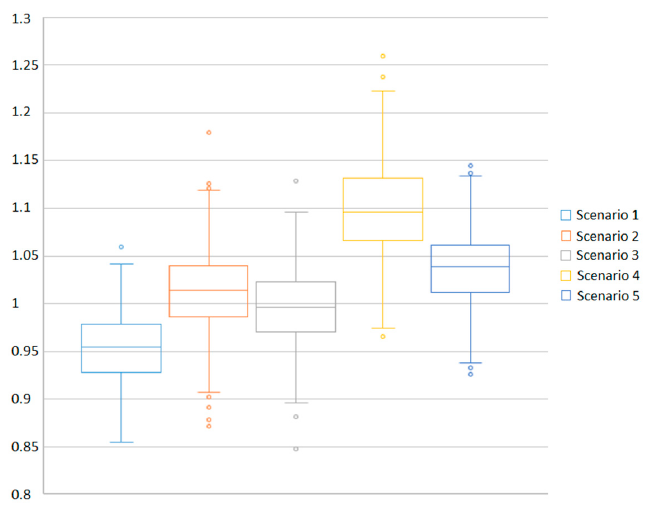
Figure 9. Impact of traffic organisation on the roundabout capacity.